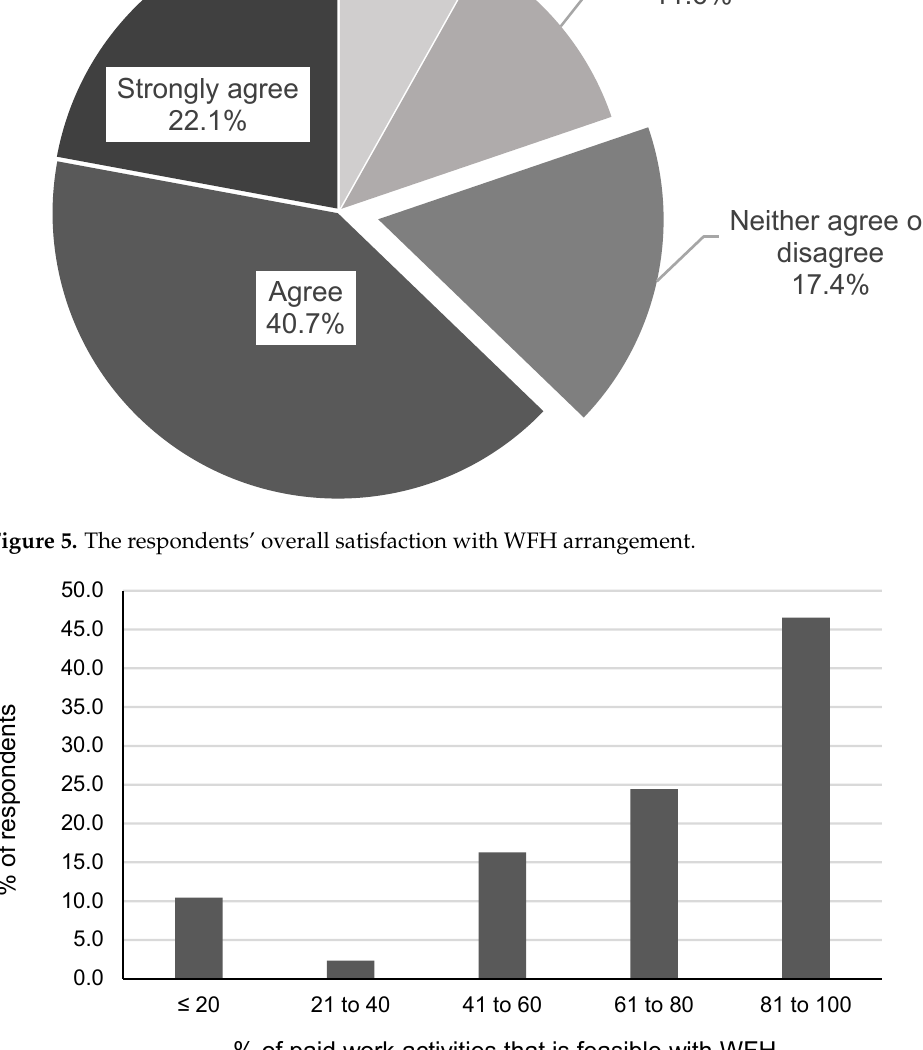
Figure 6. Percentage of paid work activities that was feasible with WFH arrangement.